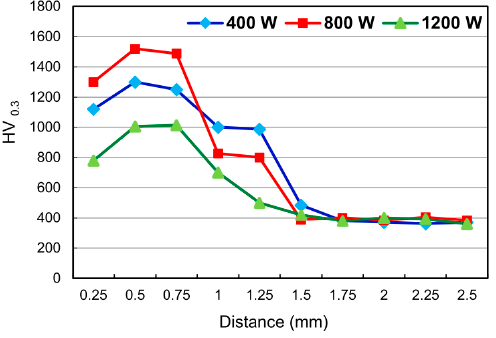
Figure 11. Cross-sectional hardness profiles of FA/ZrO 2 specimens prepared using different laser Figure powers.